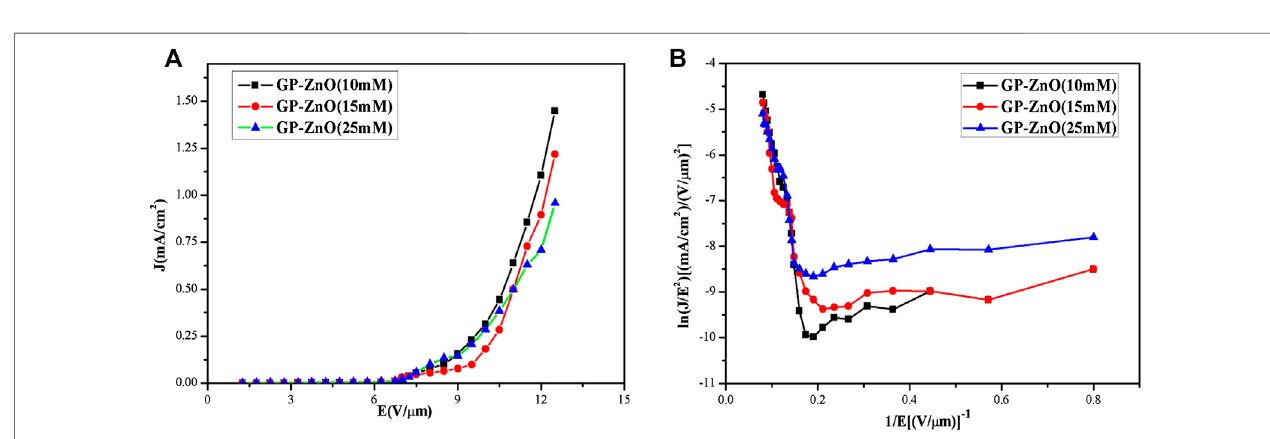
FIGURE 7 | (A) Emission current density vs. electric fi eld curves and (B) F – N plot of graphene/ZnO nanorods at different concentrations of